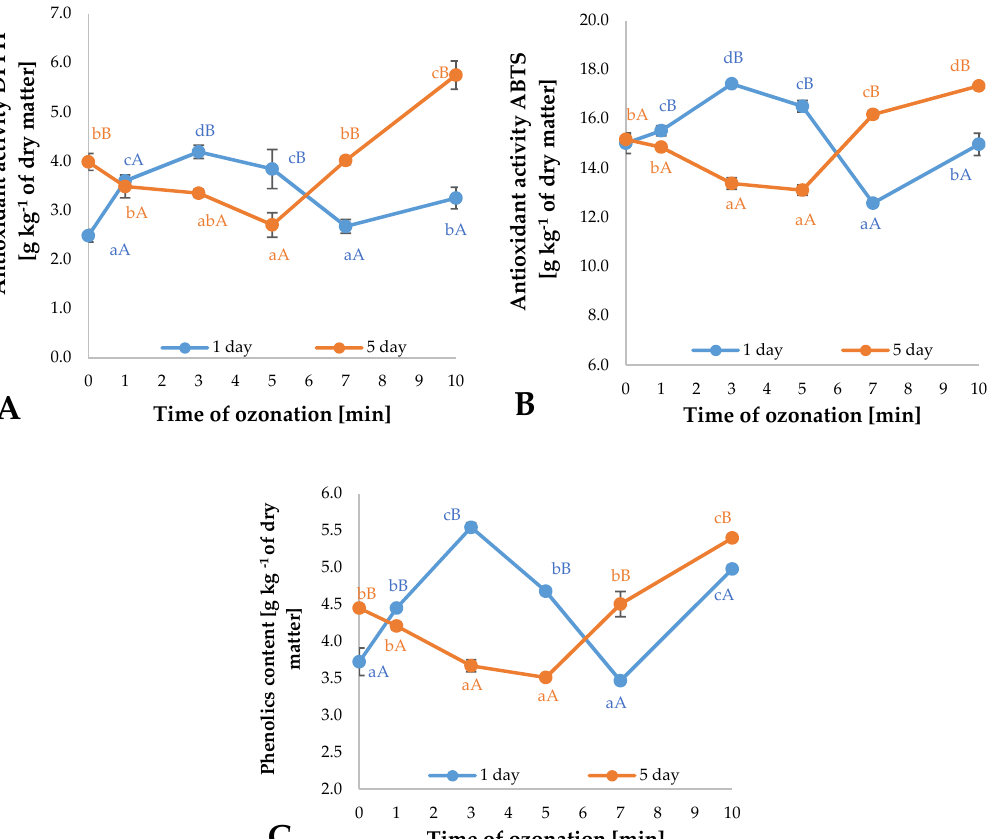
Figure 1. Antioxidant activities (DPPH (2,2-difenylo-1-pikrylohydrazyl) test ( A ), ABTS (2,2 ′ -azynobis-(3-etylobenzotiazolino-6-sulfonian) test ( B ) and total polyphenolic content ( C ) in Origanum majorana L. leaves depending on the time ozonation (n = 3): differences in results between the time of ozonation in current days are indicated by different small letters, and difference between terms of measurements are indicated by different capital letters; difference is noted at significant level p < 0.05.